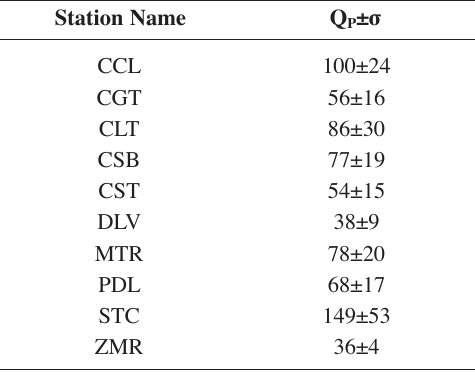
Table IV. Q P values and relative errors at each seis- mic